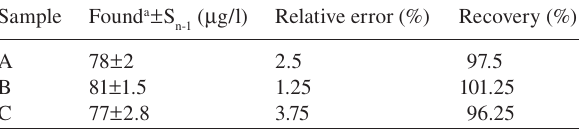
Table 4 Determination of 80 µ g/l Rh(III) in synthetic samples.